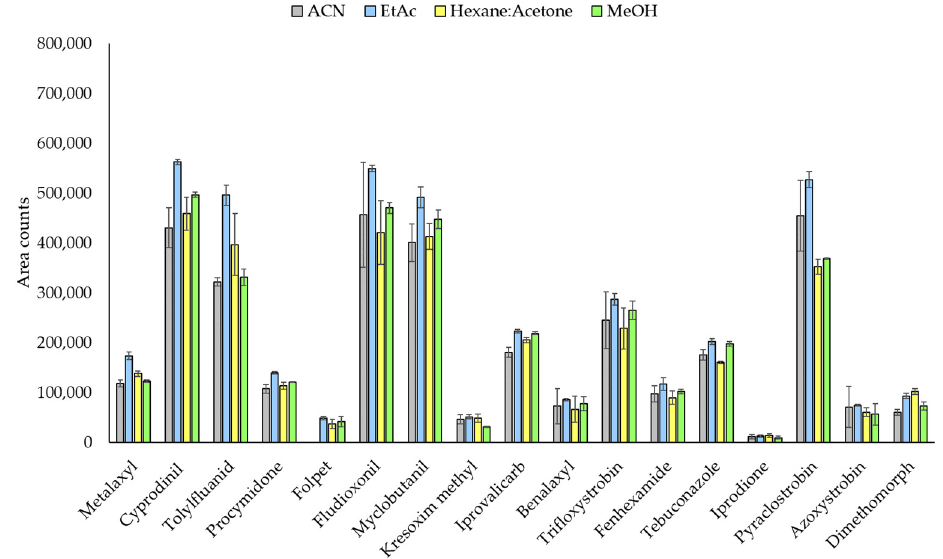
Figure 2. Fungicide peak areas for spiked vine leaves (400 ng g − 1 ) extracted by UAE using different solvents: ACN, EtAc, Hexane:Acetone (50:50, v / v ) and MeOH.